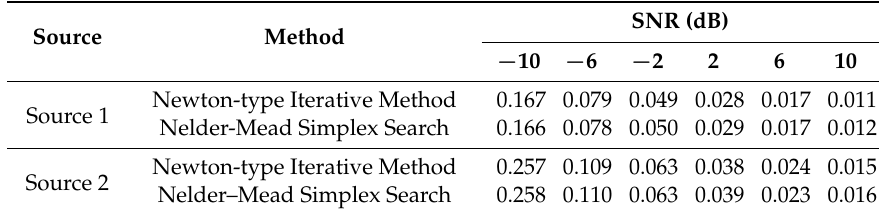
Table 3. The estimated RMSEs of the proposed DPDs using the Newton-type iterative method and Nelder–Mead simplex search for near-field sources (km).